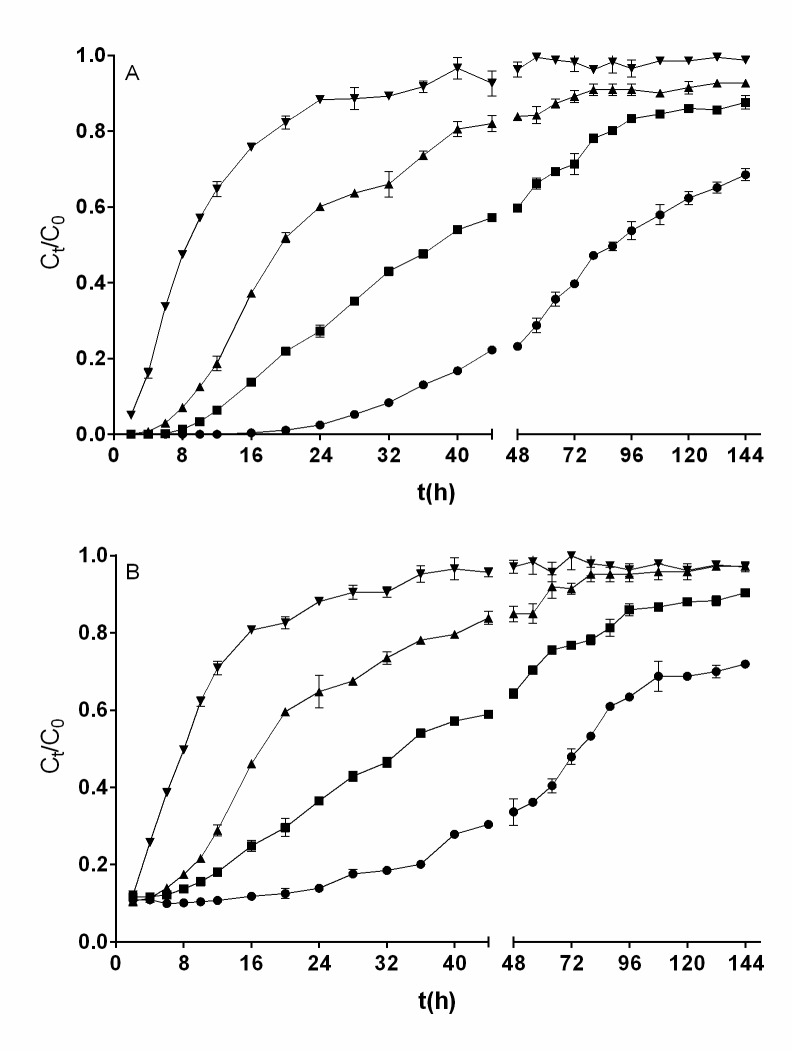
Influence of influent Cr(VI) concentration on the breakthrough curve for removal of Cr(VI) (A) and total chromium (B) by QCS [Cr(VI) concentration (mg L-1): ●, 50; ■, 100; ▲, 200; ▼, 400]. Conditions: influent flow rate, 0.75 mL min−1; bed height, 3.5 cm; solution pH, 2.0. When they do not appear, standard deviation bars are smaller than the size of the symbols.